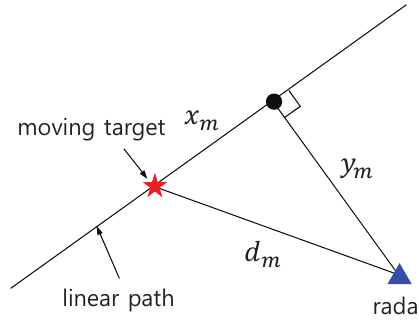
Figure 9. Test scenario.